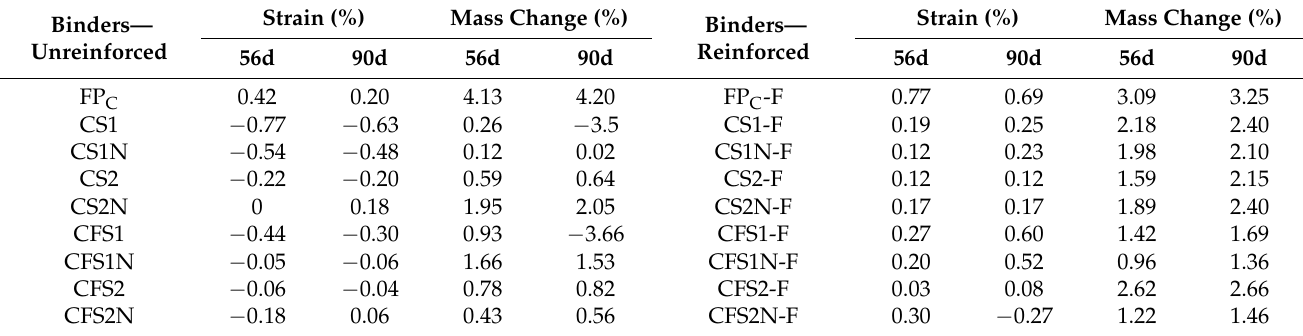
Table 3. Length and mass change of binders without and with fibers in water curing regime.